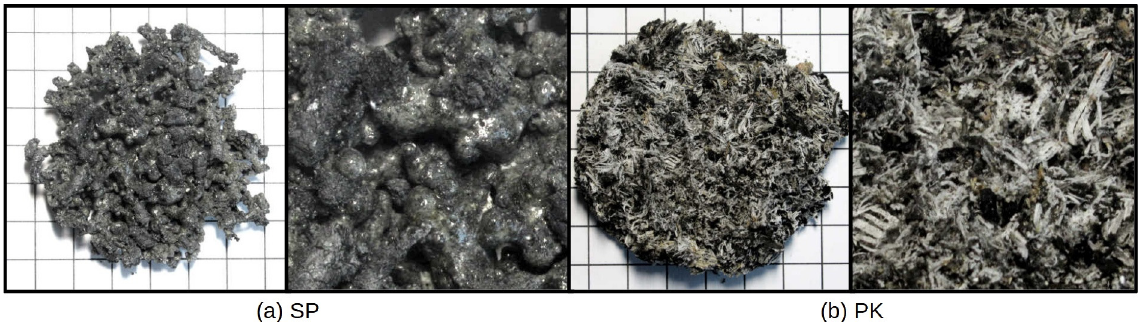
Figure 10. Ash formation within the process; ( a ) Wheat straw pellets; ( b ) Palm kernel shells; edge length of a box is 1 cm.